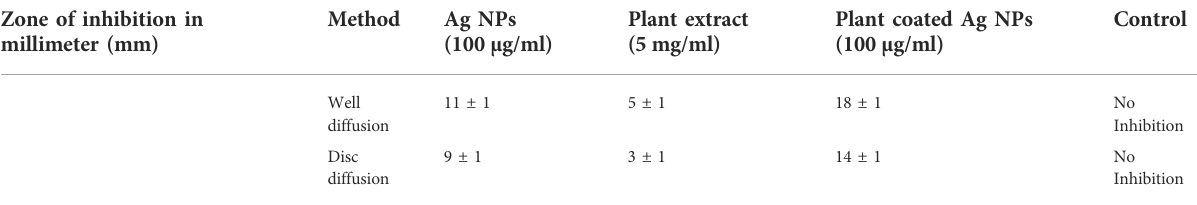
TABLE 1 Zone of inhibition (in millimeter) of F. oxysporum in disc and well diffusion method. Zone of inhibition in millimeter (mm)